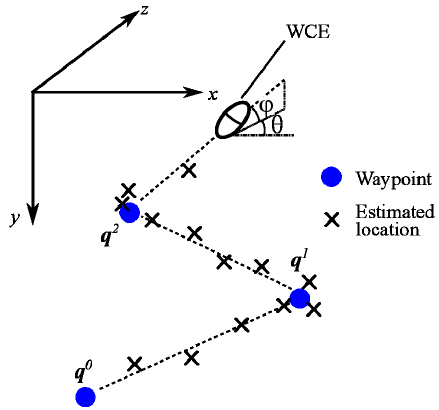
Figure 1: Example of WCE movement.